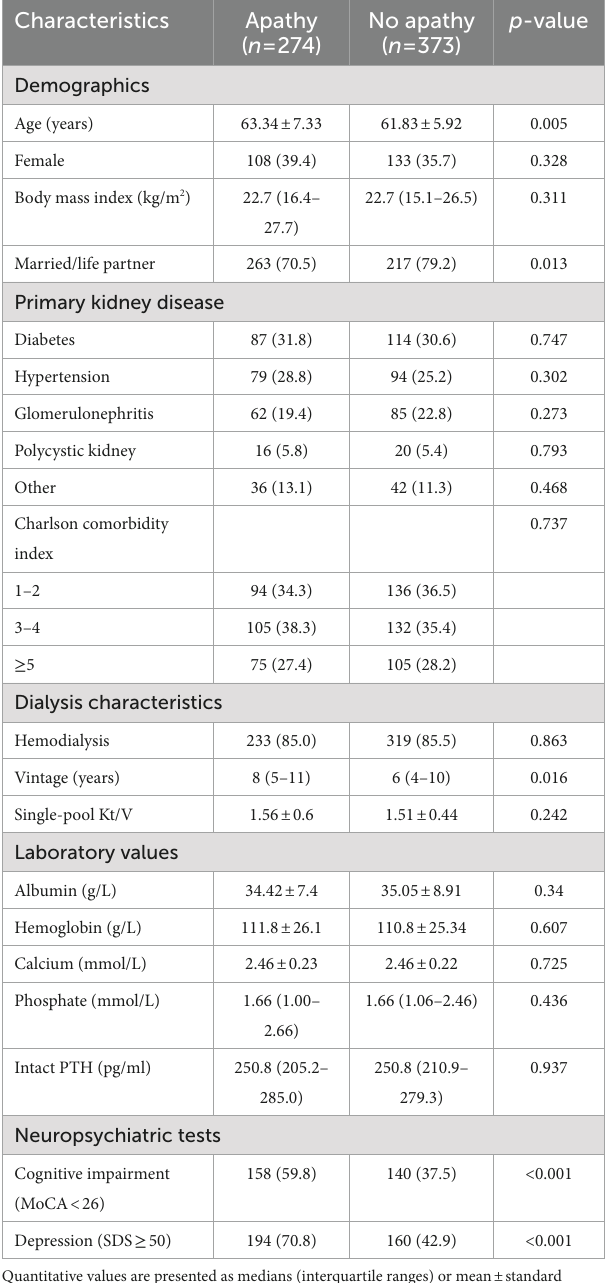
TABLE 1 Baseline characteristics of dialysis patients by apathy status.